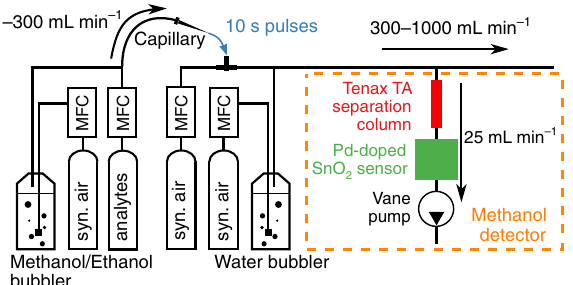
Fig. 7 Schematic of the synthetic gas mixing setup and the methanol detector. The methanol detector (orange box) consisting of the packed bed separation column of polymer (Tenax TA, red) particles, followed by the chemoresistive (Pd-doped SnO 2 , green) sensor and the vane pump that draws 25 mL min − 1 of gas sample. For characterization with synthetic gas mixtures, the detector is connected to a gas delivery system. It supplies the detector with a constant fl ow of humidi fi ed air by mixing dry and humidi fi ed synthetic air (syn. air). Analyte exposures are generated by admixing analytes from calibrated gas standards or by bubbling syn. air through analyte/water mixtures to the humidi fi ed syn. air stream with a capillary through a septum. Flows are accurately controlled by calibrated mass fl